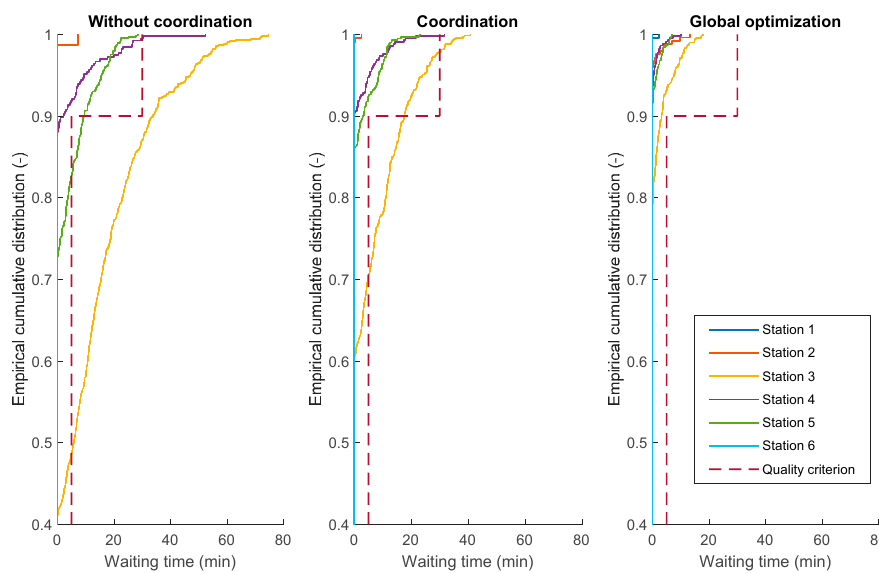
Figure 13. Waiting times at charging station, 3 charging points per station.